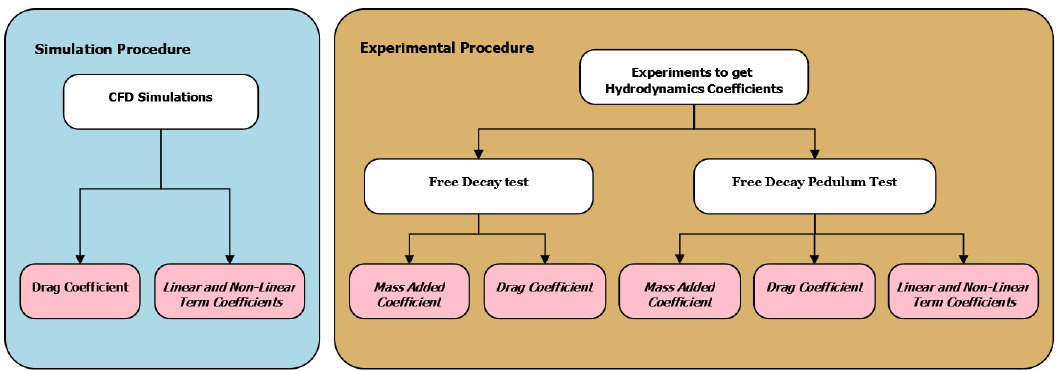
Figure 2. The proposed methodology for obtaining the hydrodynamic coefficients from the experimental procedure. On the right side, the two experiments based on free decay tests are shown. On the left side, a description of the simulation procedure to obtain the values for the drag coefficient and linear and nonlinear term coefficients is shown.